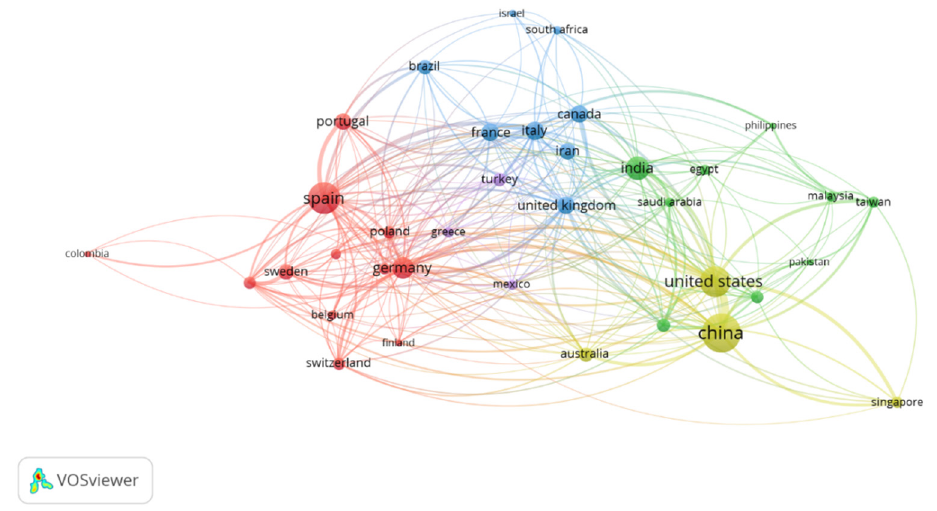
Figure 4. International cooperation based on co-authorship between countries.